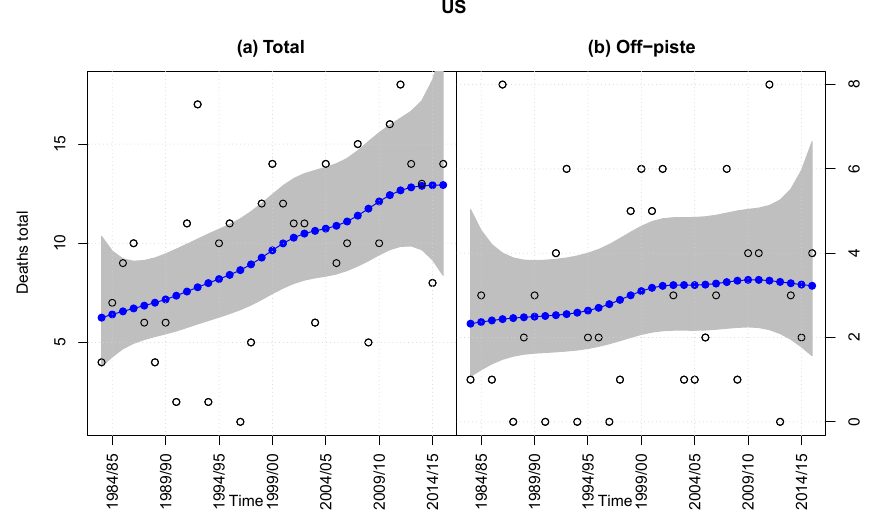
) annual avalanche fatalities – off-piste and backcountry, i.e., total (a) , and off-piste (b) – with 90% Figure 6. Observed ( ◦ ) and estimated ( • confidence bands (grey) in the US within